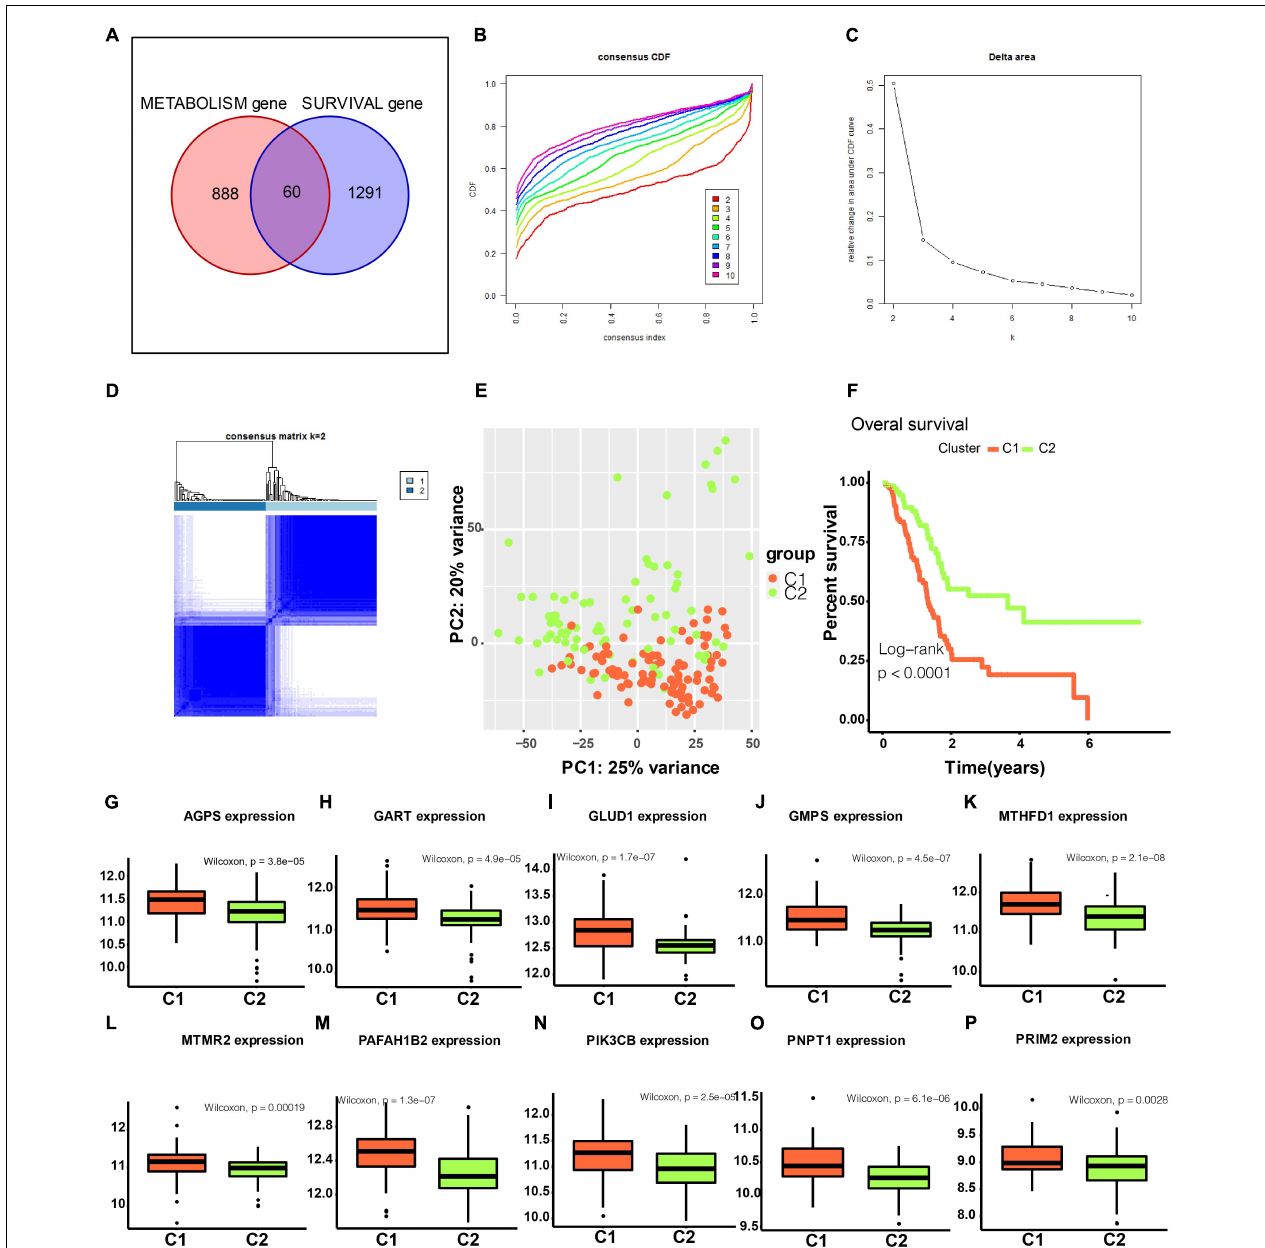
FIGURE 2 | Identification of two metabolism-associated subtypes. (A) In total, 60 genes were identified in the intersection between survival-associated genes and metabolism-related genes. (B) CDF curve for different k-values (representing the number of clusters in the consensus clustering analysis). When the optimal k-value is reached, the area under the CDF curve does not increase significantly as the k-value increases. (C) Relative change in the area under the CDF curve for different values of k. (D) Consensus matrix obtained when k = 2. Consistency values range from 0 to 1, where 0 indicates that genes never cluster together (white) and 1 indicates that they always cluster together (dark blue). (E) PCA showed a significant difference between subtypes. (F) Survival curves for patients with different subtypes. (G–P) Boxplot depicting expression levels of some metabolic genes in the C1 and C2 subtypes. CDF, cumulative distribution function. PCA, principal components analysis. P < 0.05 is defined as statistically